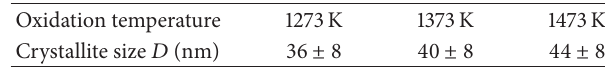
Table 2: Crystallite sizes versus oxidation